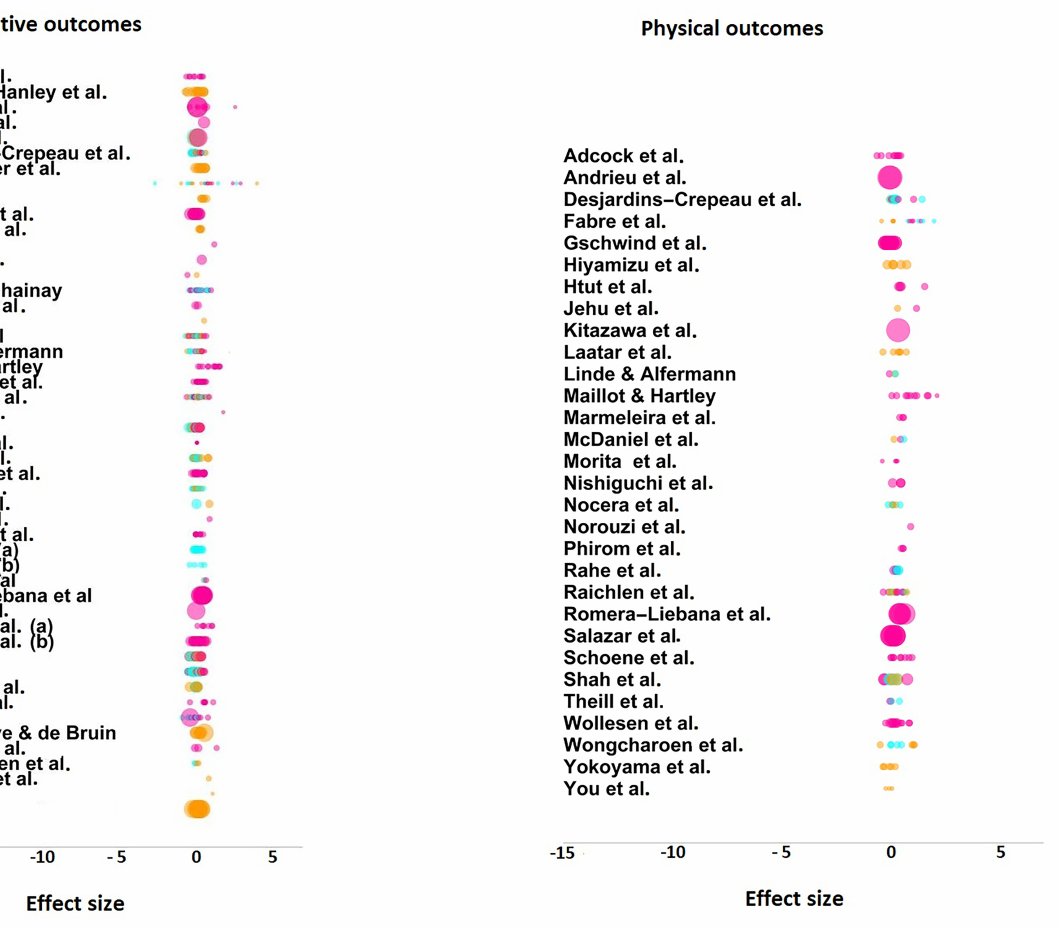
FIGURE 3 | Dot-plot figures for effect sizes for cognitive outcomes and physical outcomes by primary studies. Pink dots represent combined training vs. control, blue dots represent combined vs. single cognitive training, and orange dots, combined vs. single physical training. The size of the dot indicates the inverse of the ES variance scaled and represents the precision of the